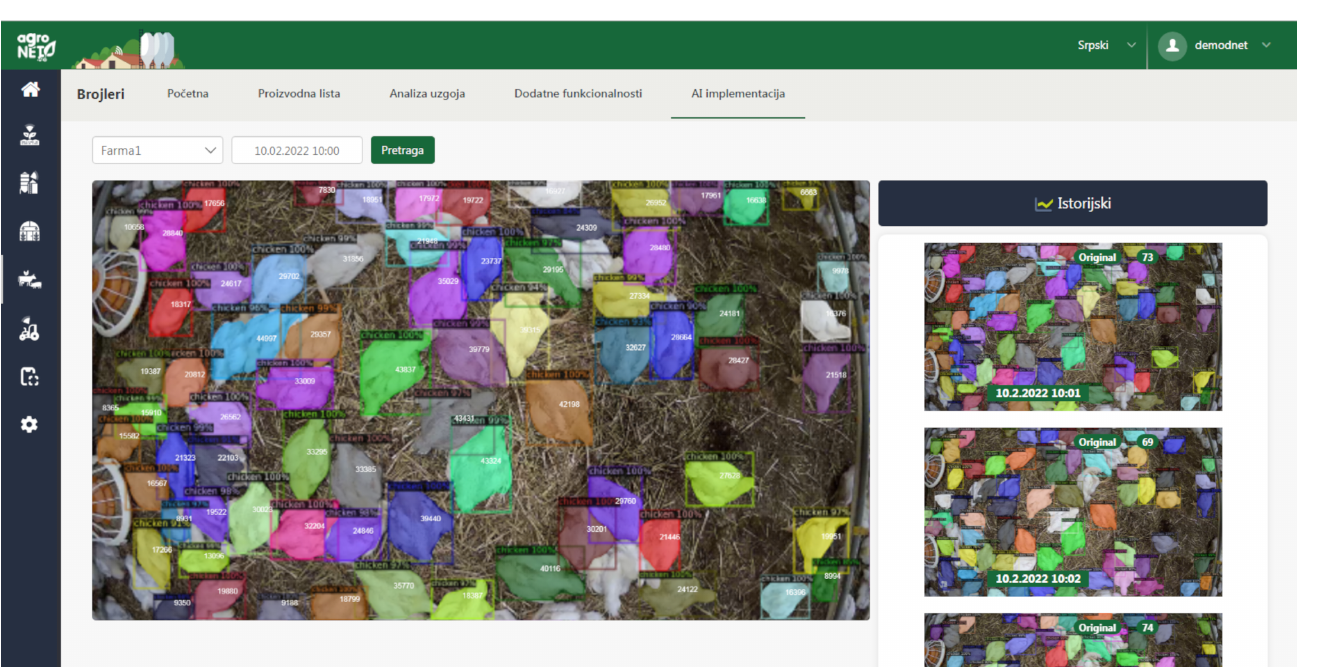
Figure 7. Integration with an existing digital farming